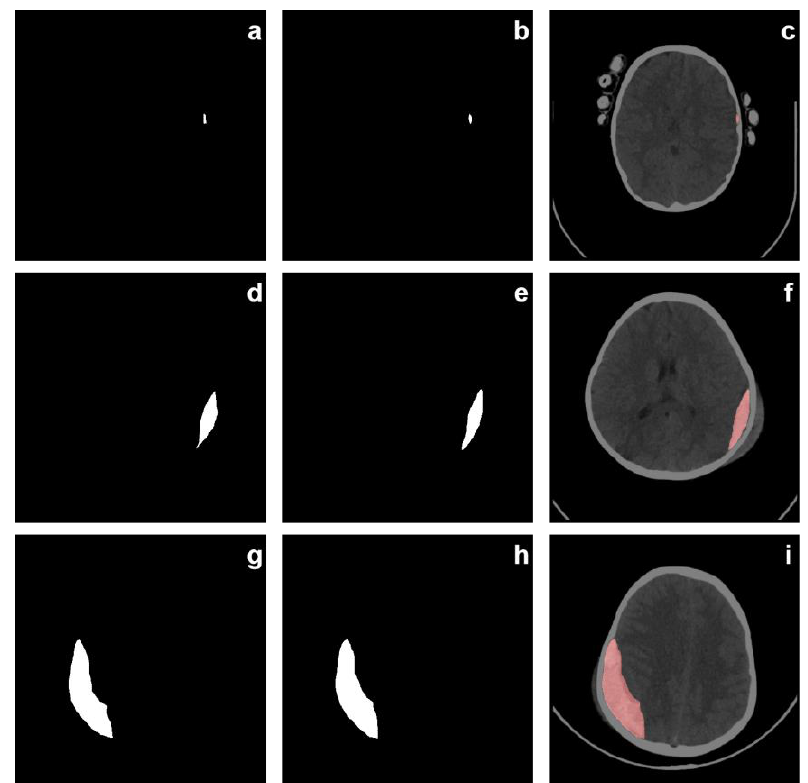
Fig. 4. The ground truth and output results of three samples involving small, medium, and large objects from the validation set. The (a, d, and g) are the ground truth from radiological labels of dataset, the (b, e, h) are the predictive results of the best model, and (c, f, i) are the blending results of the original images and predictive labels. Figure 4 shows that the final model performed well using a validation set for the detection of position and size. The shapes of the edges of the predictive label were smoother than the ground truth, which caused some false detection, especially on small objects, when compared with Figure 4(a) and